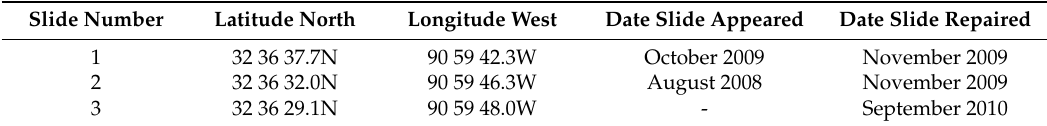
Table 1. Updated slides ground truth from Mississippi Levee